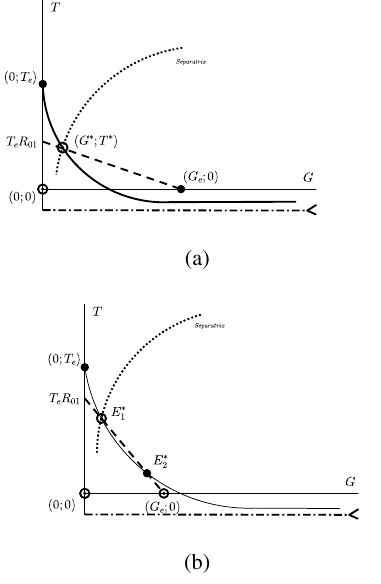
Fig. 4: Different equilibria and their stability/instability properties when R 01 < 1 and ω ( G e ) R 10 < 1 . (a) presents two basins of attraction divide by a separatrix: one to the stable grassland equilibrium; one to the stable woodland equilibrium (bistability as in Table II). (b) is the same as (b) in Fig 2 except with ω ( G e ) R 10 < 1 . savanna and forest as alternative stable states.